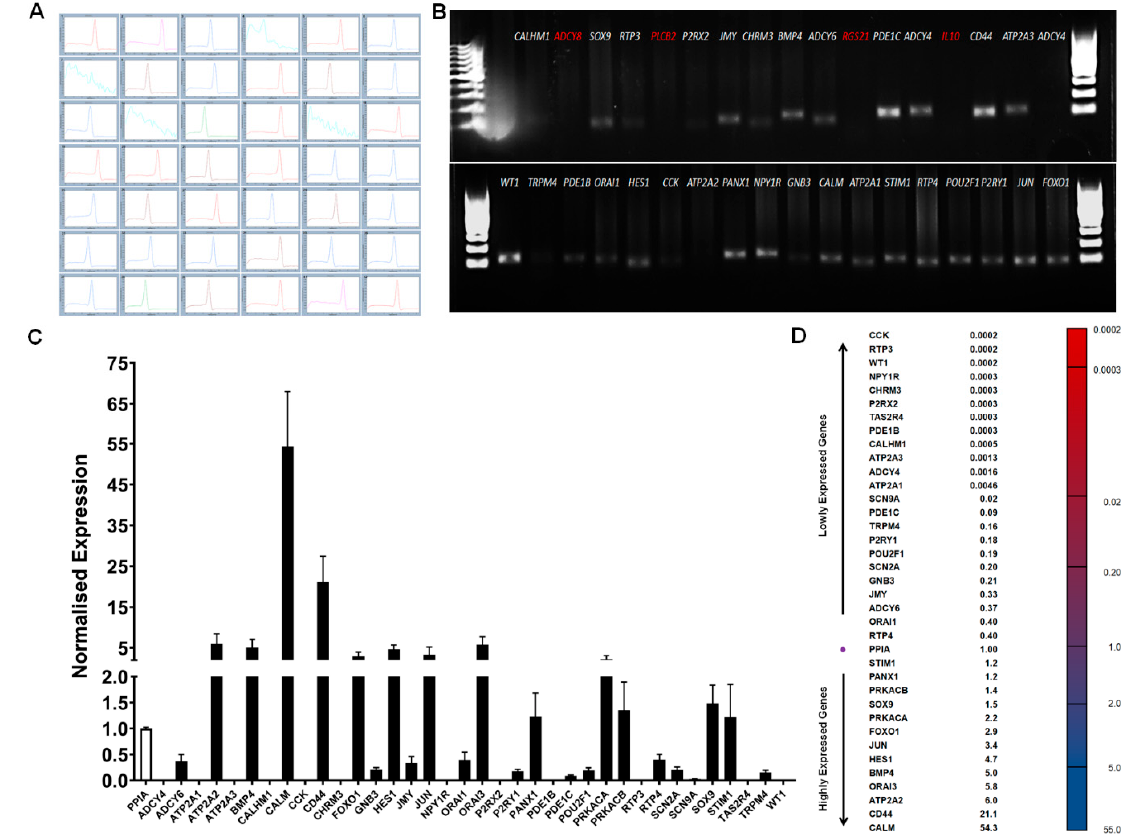
Figure 9. RT-qPCR array-based quantification of genes involved in taste transduction: ( A ) Melting curve analysis of 42 array genes; no melting peak was observed for the primer sets of IL10 (4) , RGS21 (7) , PLC β 2 (14) and ADCY8 (17). The X-axis represents temperature (°C) and the Y-axis represents negative first derivative of fluorescence with respect to temperature ( − dF/dT). ( B ) Agarose gel analysis of 35 array genes following a qPCR reaction. A single PCR product with a correct amplicon size was observed for all genes except for the primer sets of IL-10, RGS21, PLC β 2 and ADCY8 . ( C ) Quantification of taste gene mRNAs using custom made RT-qPCR array; each cDNA was normalised to the reference gene PPIA and normalised expression level (y-axis) of each gene was quantified using 2 −Δ Cq method. Data reported as mean of relative expression of four independent experiments and bars indicate standard error (±SE). ( D ) Expression profile of RT-qPCR array genes arranged from lowly to highly expressed in BTBCs.